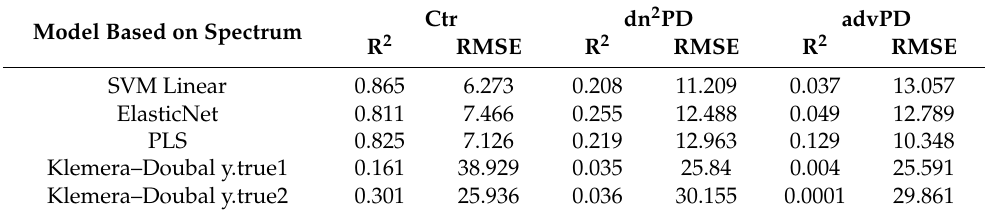
Table 3. Table reporting performance for SVM, PLS, and ElasticNet. The Klemera–Doubal baseline is also presented. Binned spectra are used as input features. Model Based on Spectrum